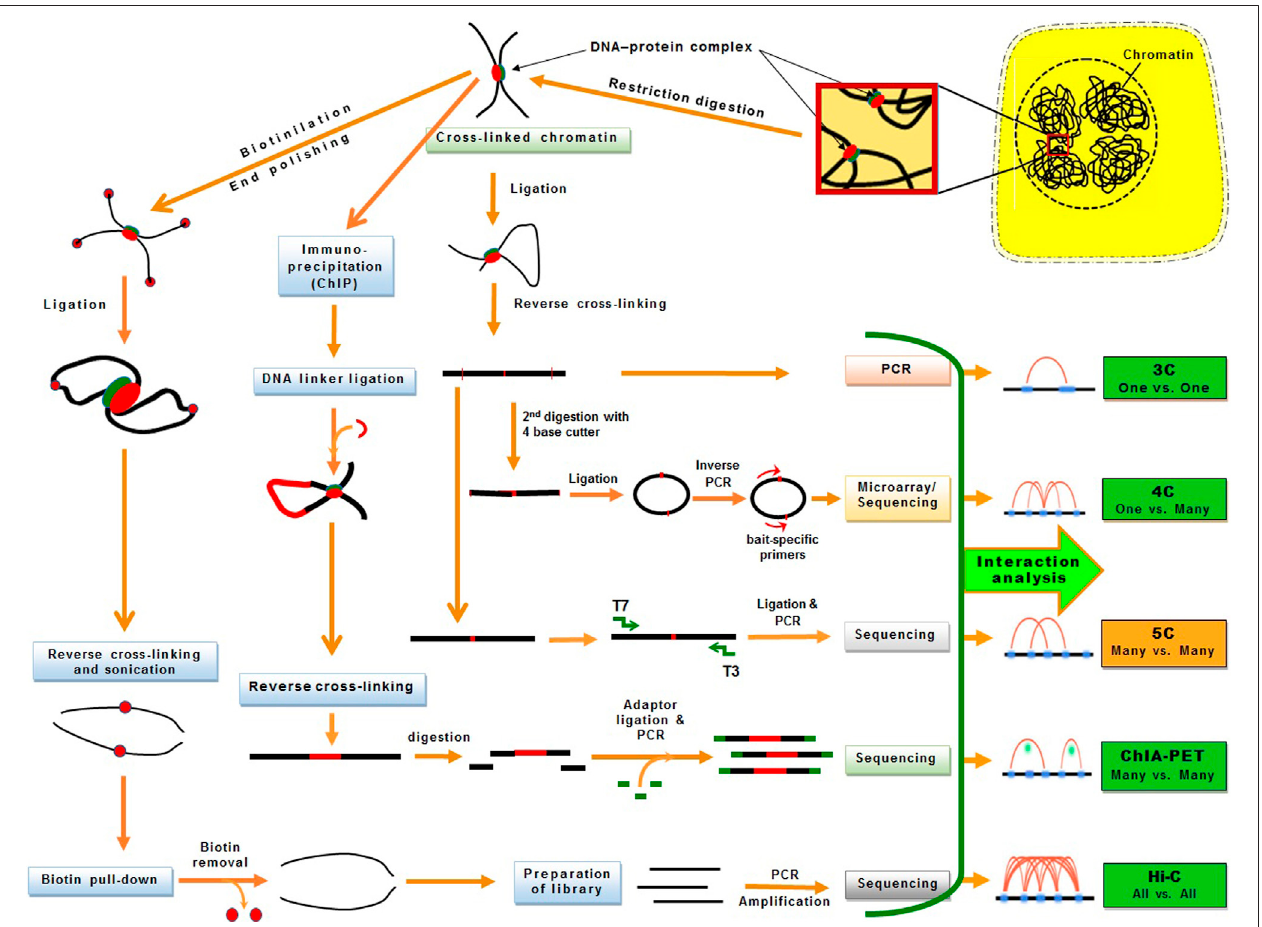
FIGURE 3 | An overview of the chromatin conformation capture (3C) and its derivative techniques used for 3D genomic studies. The DNA − protein interactions are fi xed invivo usingformaldehydeandthenchromatinsarefragmentedbyrestrictionendonucleasetreatment.Thecross-linked chromatinsareprocesseddifferentiallyfor one vs one (3C), one vs many (4C), many vs many (5C, ChIA-PET), or all vs all (Hi-C) interaction analysis. The techniques successfully used in plants are presented in green boxes.